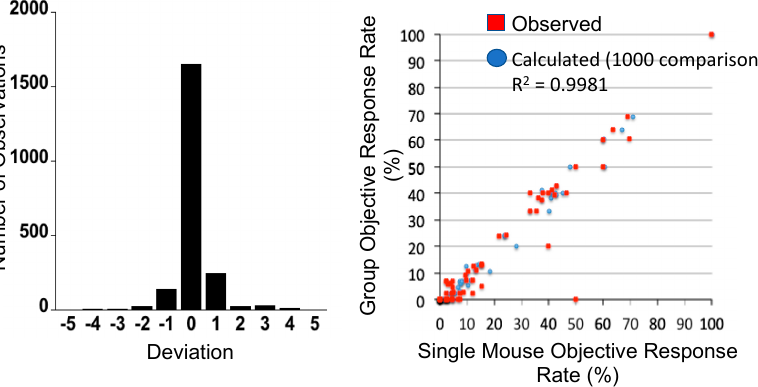
Figure 2. Left : Distribution of deviation for 2134 observations. Single mouse prediction of response was compared to the median response for groups of tumor-bearing mice. A score equaling zero indicates accurate prediction, whereas +1 and − 1 refer to over- and under-prediction by one response classification. Right : Objective response rates (ORR) were calculated for all tumor models tested for a particular drug (1 to 55 models) for different studies, based upon the Group Median response; (red) responses predicted from a randomly chosen single mouse are plotted against group median response; (blue) the Single Mouse ORR mean ORR correlation based on 1000 single mouse samples. (From [48] with permission).